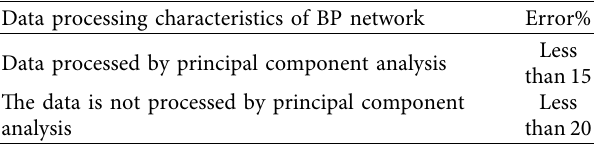
Table 6: Comparison of prediction